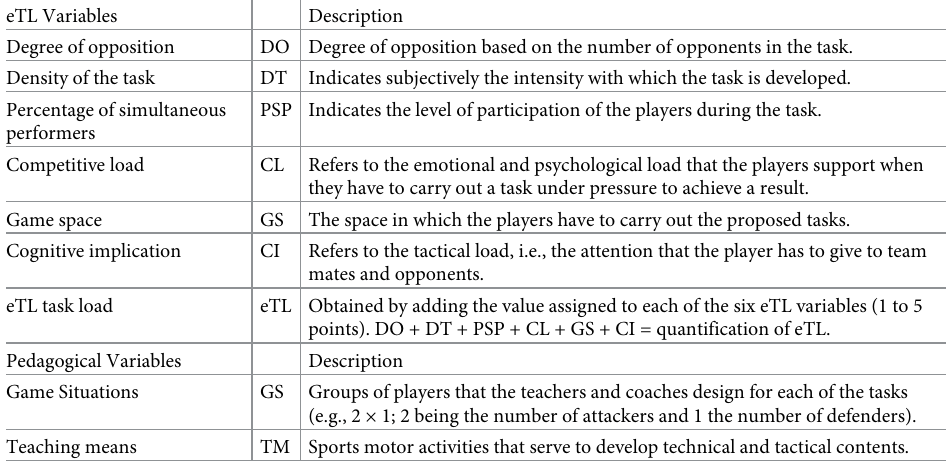
Table 1. Synthesis of the eTL and pedagogical